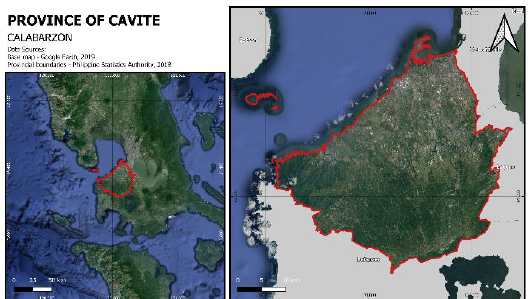
Figure 1. Study Area